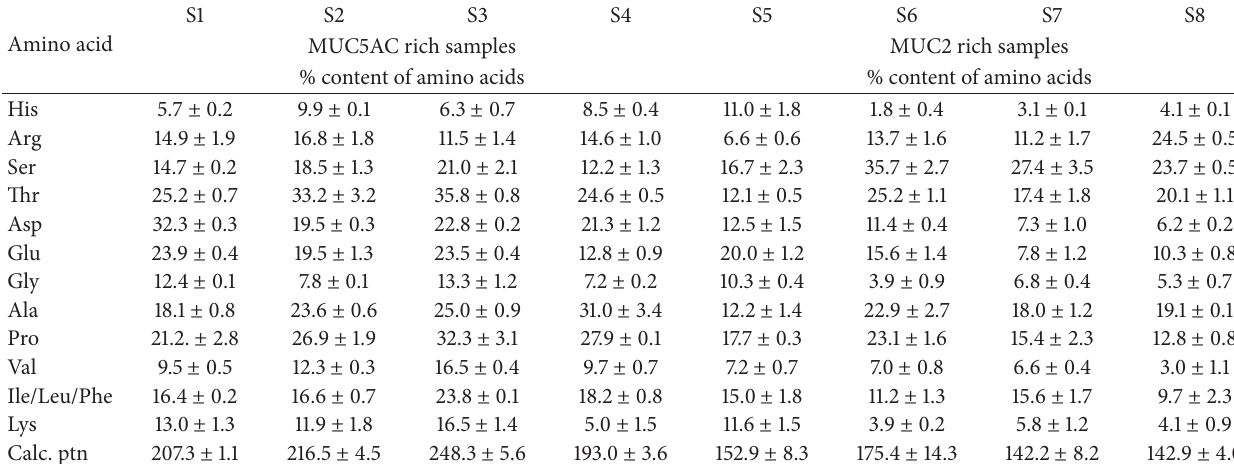
Table 1: Amino acid composition of native/polymeric chronic sinusitis mucins.